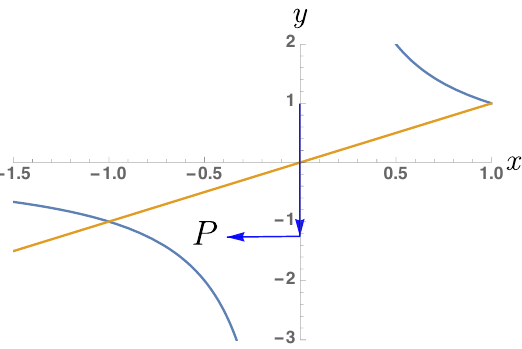
Figure 3: Integrating to a point P in the physical region. This figure is from [ 13 ] licensed under CC-BY